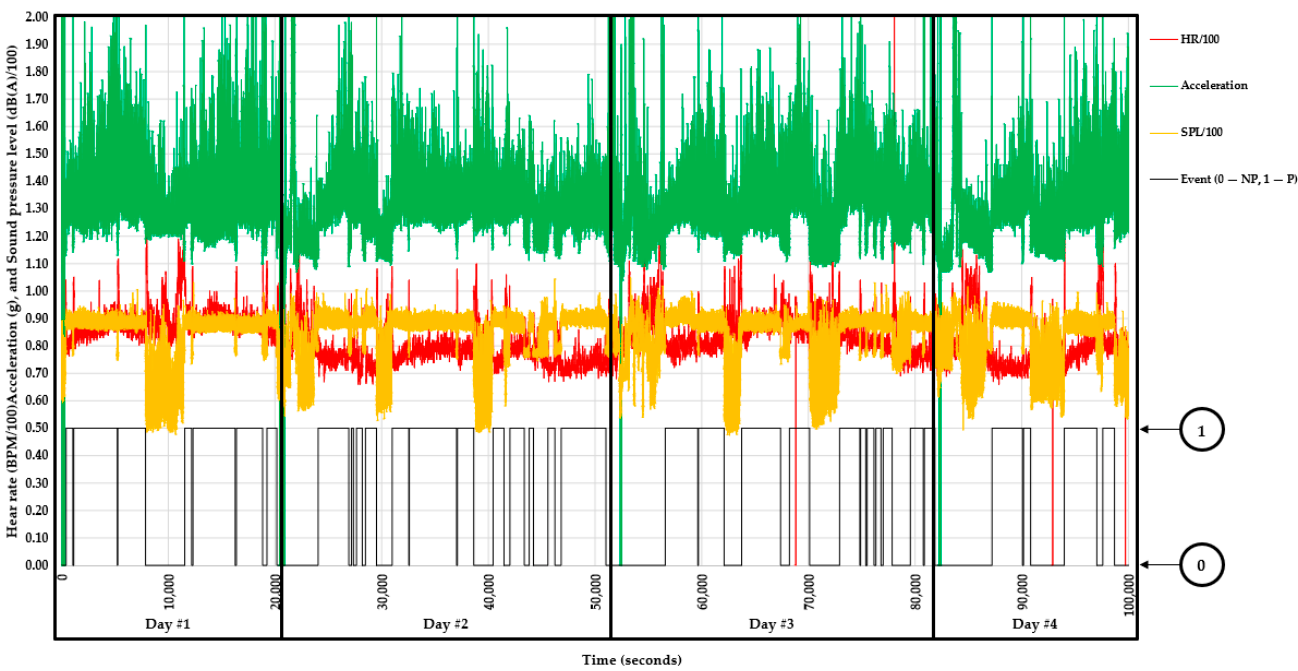
Figure 5. Variation of the heart rate, acceleration and sound pressure level in the time domain and on events. Legend: HR/100 —heart rate (beats per minute) downscaled by a factor of 100, SPL/100 —sound pressure level (dB(A)) downscaled by a factor of 100, NP —non-processing events (time), P —processing events (time).